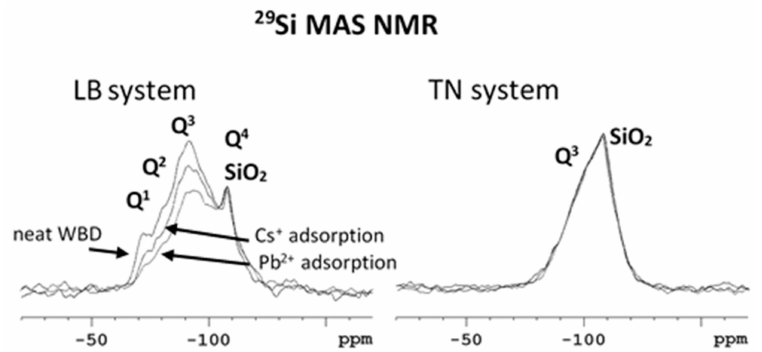
Figure 4. Comparison of 29 Si MAS NMR spectra of neat LB and TN WBD systems, before and after Cs + / Pb 2 +